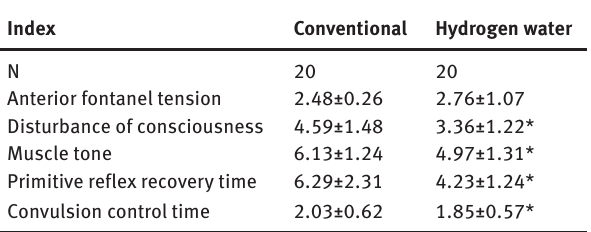
Table 2: A comparison of the clinical recovery time between the conventional treatment group and the hydrogen water treatment group (x±s,